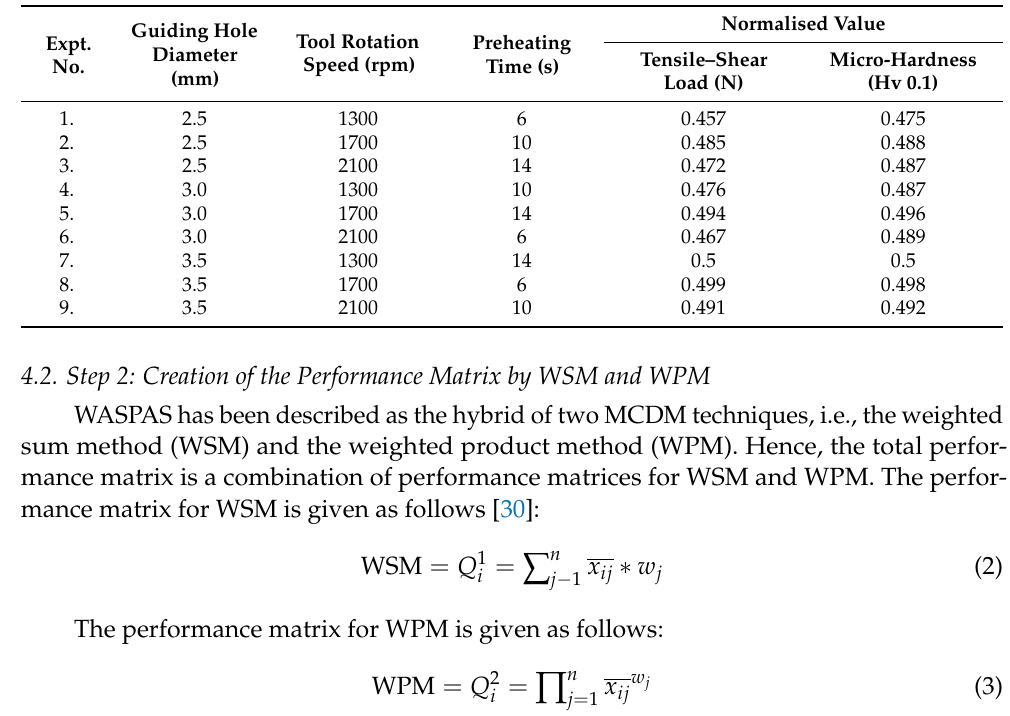
Table 3. Normalised decision